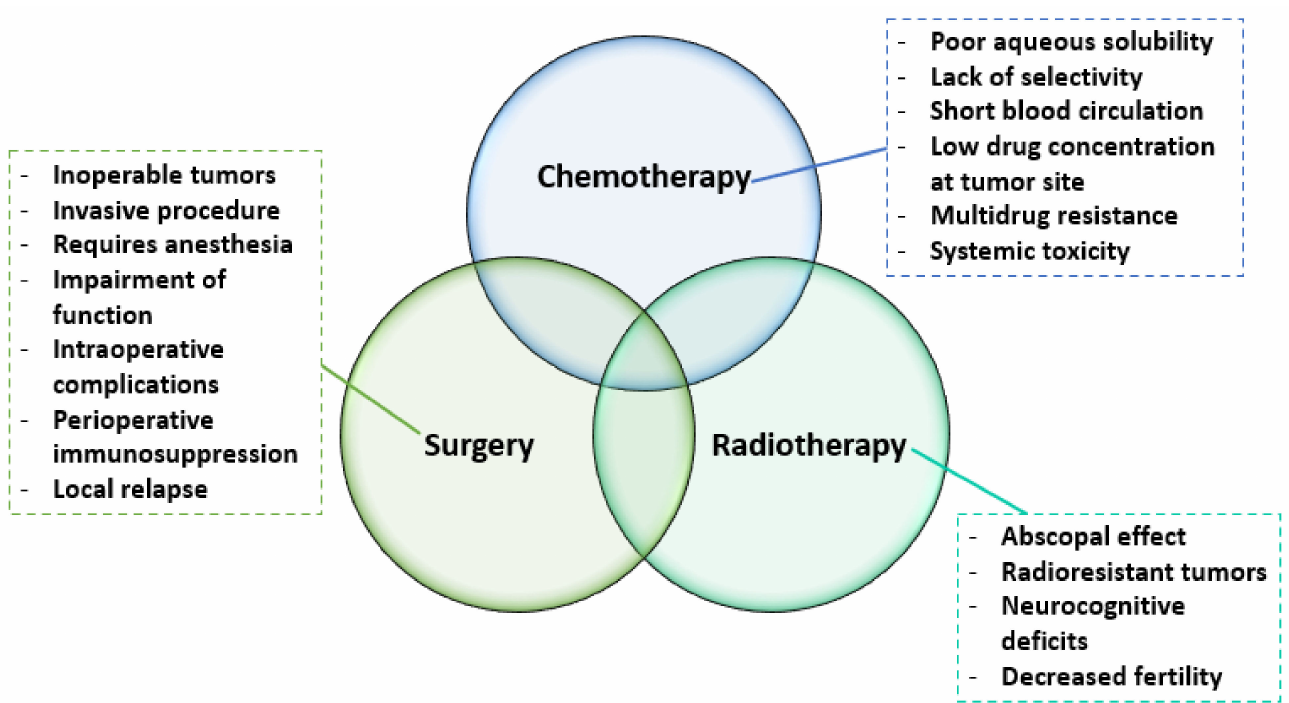
Figure 1. Limitations of conventional cancer treatment strategies. Created based on information from